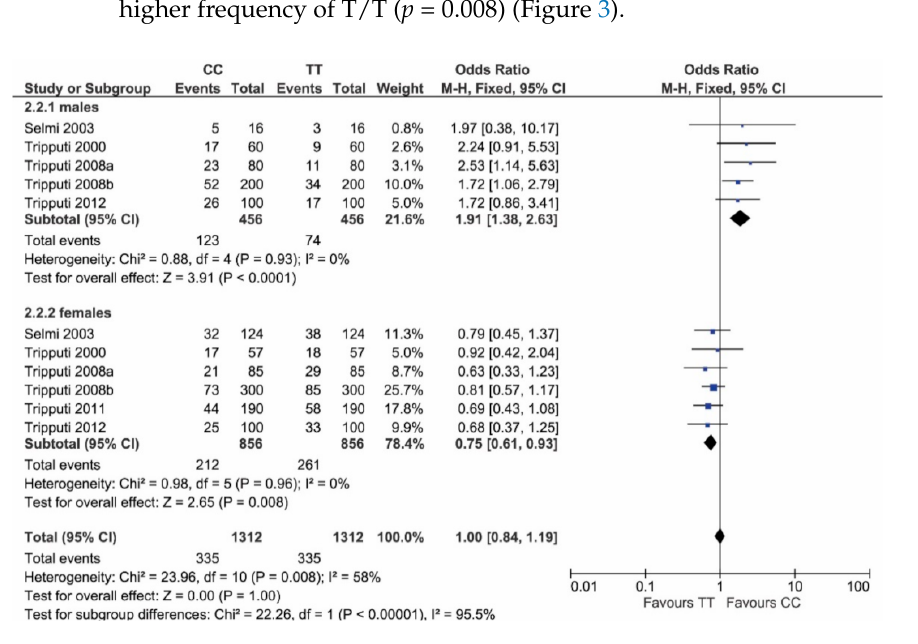
Figure 3. Forest plot comparing homozygotes genotypes (T/T and C/C) in males versus females. In males (plot above), C/C has higher frequency than T/T, while, in females, T/T has higher frequency than